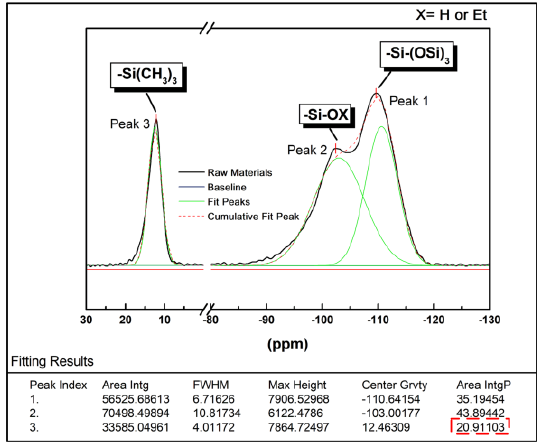
Figure 1. 29 Si MAS-NMR spectra of HMDS-modified silica NPs.